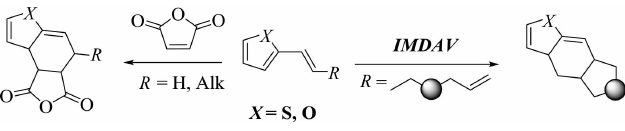
Figure 1 Intra- and intermolecular Diels–Alder reaction in vinylfurans and vinylthiophenes in the synthesis of benzofurans and